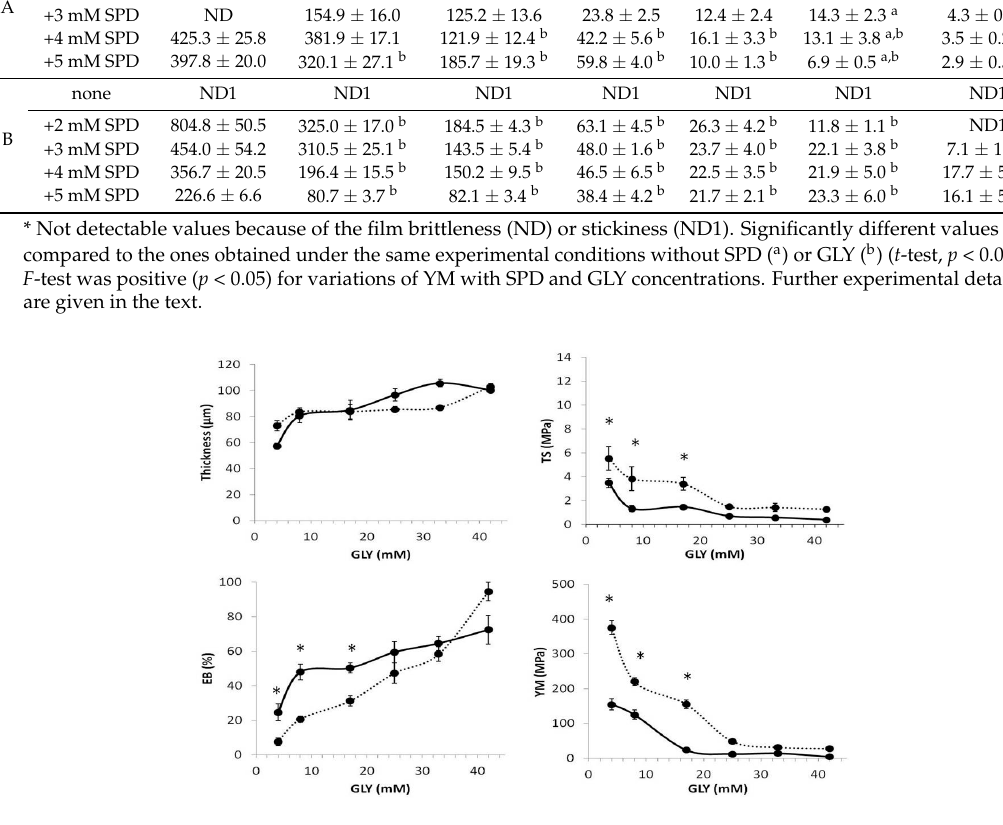
Figure 1. Effect of different GLY concentrations on the mechanical properties of films prepared with BV proteins treated at 25 °C, in the presence of 3 mM SPD at either pH 8.0 (solid line) or pH 11.0 (dotted line). Brittle and unhandleable films were obtained by casting FFSs prepared in the absence of GLY. The results are expressed as mean ± standard deviation (* values significantly different at p < 0.05). Further experimental details are given in the text.